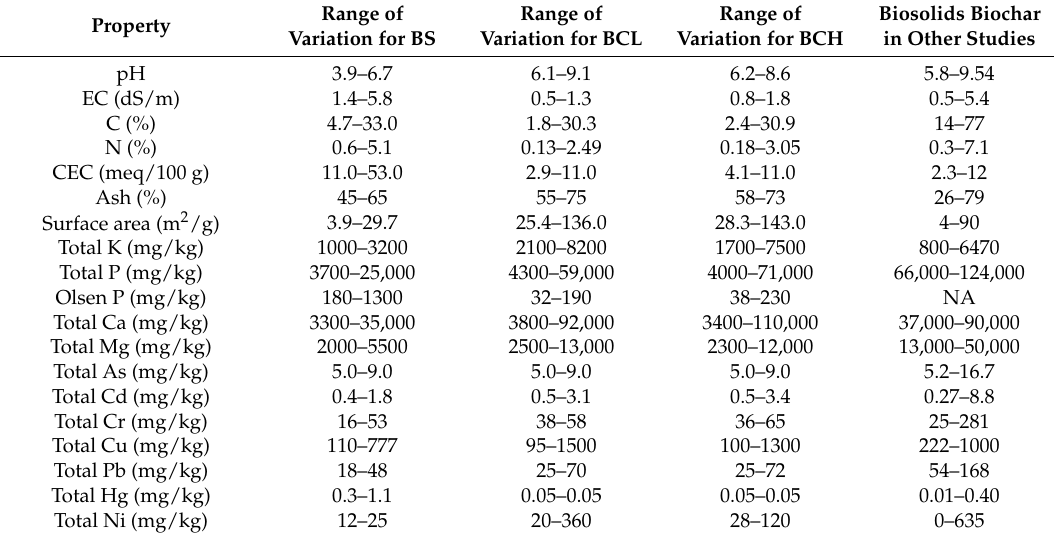
Table 2. Variability in the physicochemical properties of the biosolids (BS) and biochars prepared at low (BCL) and high (BCH) temperatures. The three middle columns show the data in our study, while the data in the last column were obtained from References [11–13,16,19–24]. Values for some properties were not provided in more than an article and are reported in the table as